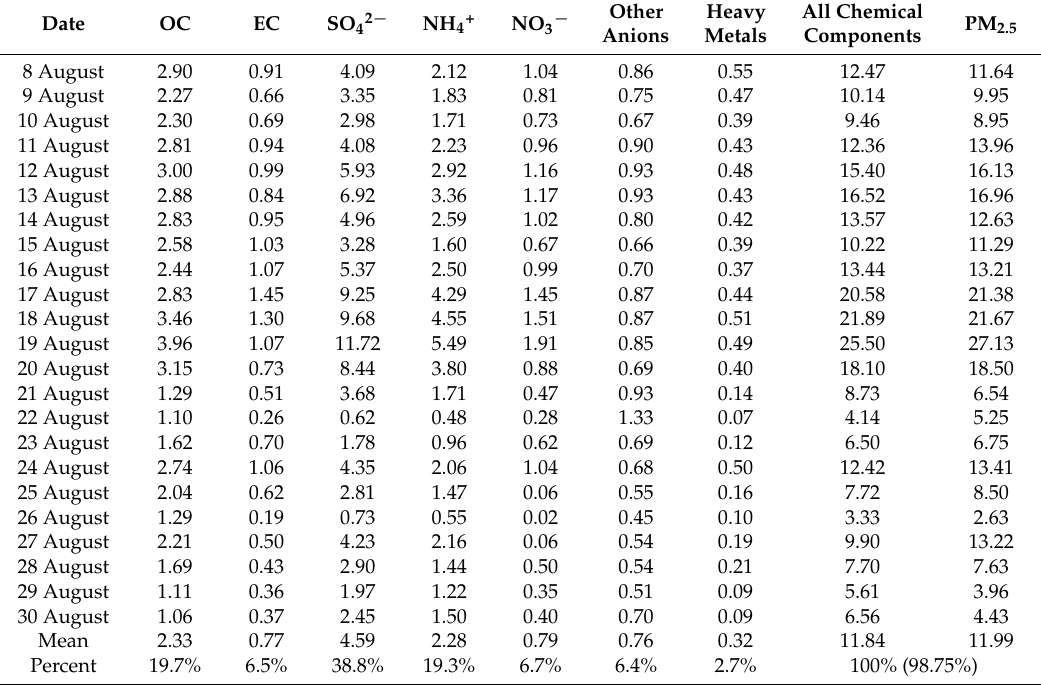
Table 1. Analysis of the daily average concentrations of the chemical components of PM 2.5 during the monitoring period (units: µ g/m 3